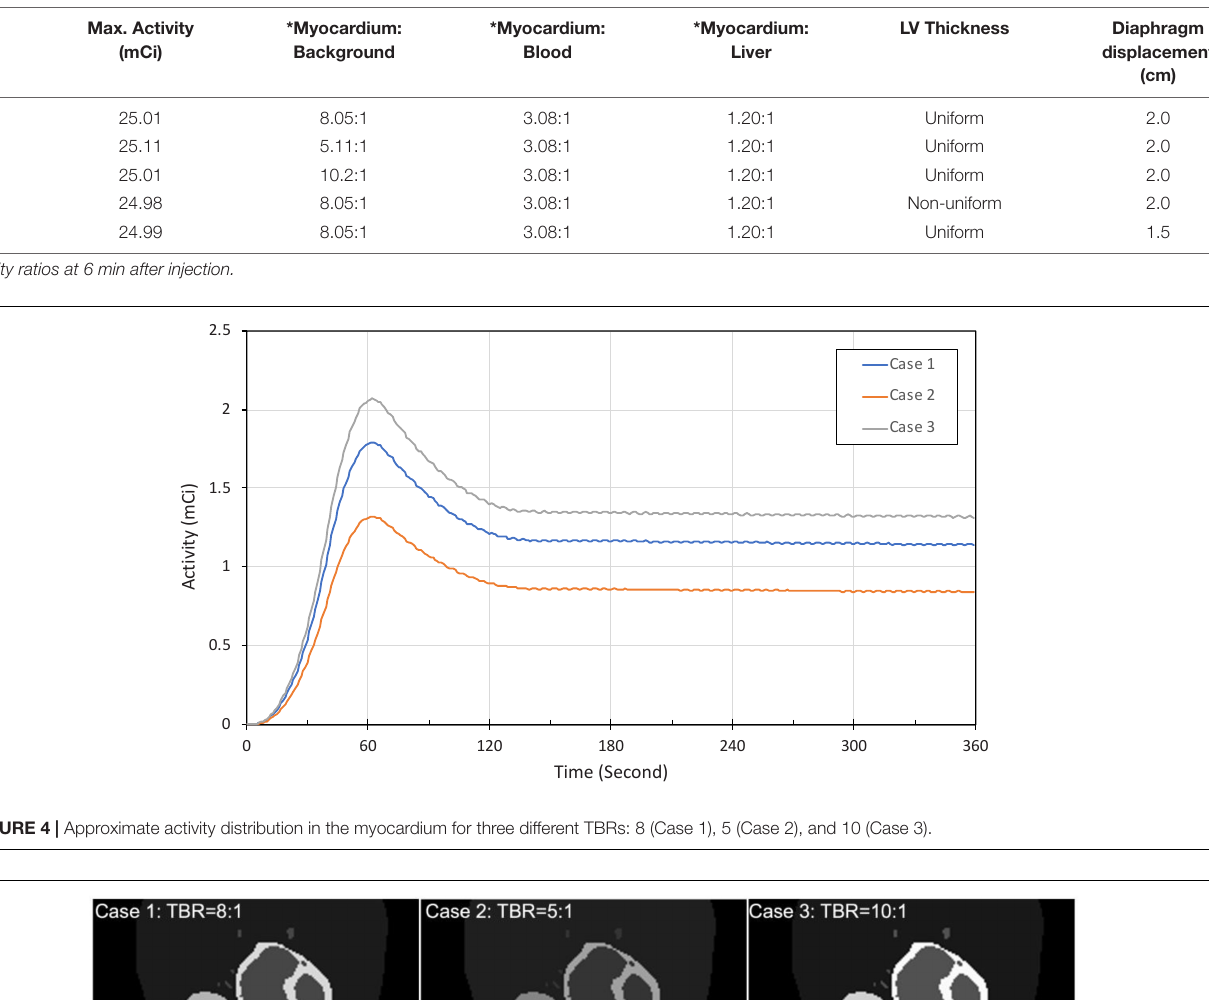
TABLE 2 | Simulation cases in this study.